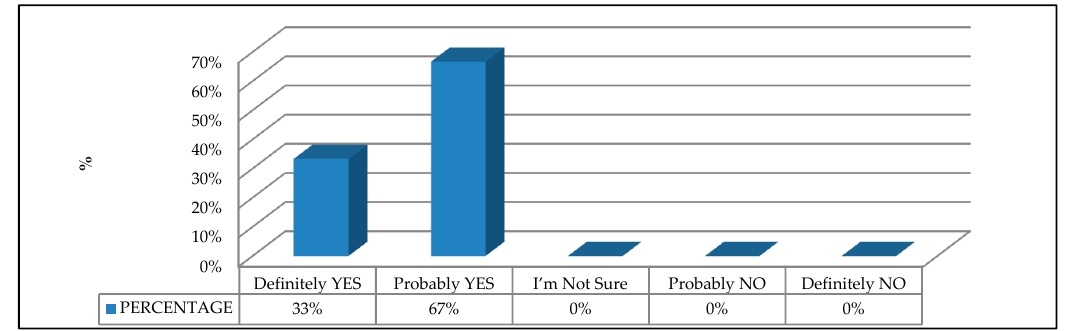
Figure 8. Evaluation of the need for a specific European Union product safety directive for access scaffolding.